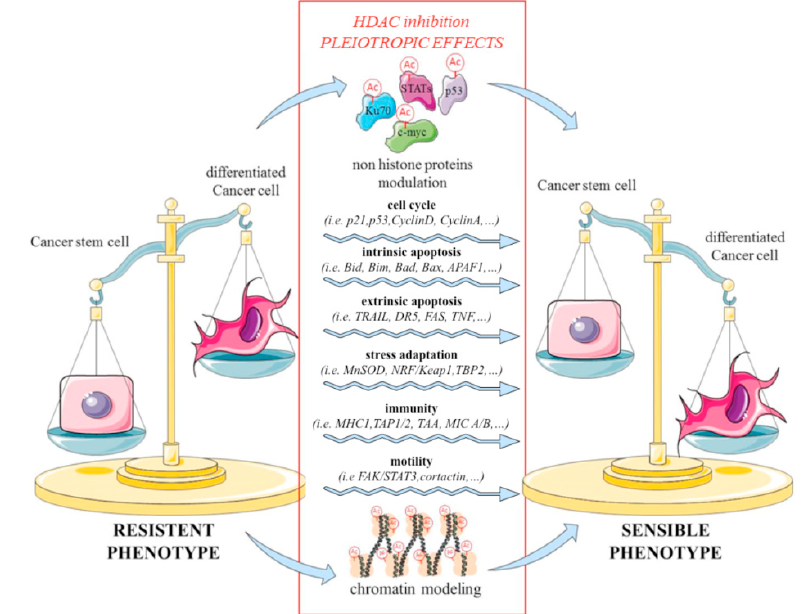
Figure 3. Histone deacetylase inhibitors (HDACi) pleiotropic e ff ects toward CSCs: HDAC are described to modulate several pathways involved in cell cycle, metabolism, stress adaptation, intrinsic and extrinsic apoptosis, motility and immunity through chromatin modeling and non histone proteins modulation. The plasticity of epigenetic regulation makes HDAC inhibition a good strategy to target CSCs chemo-resistant subpopulation in solid cancer pushing the CSCs to di ff erentiate and so gain a chemo-sensible